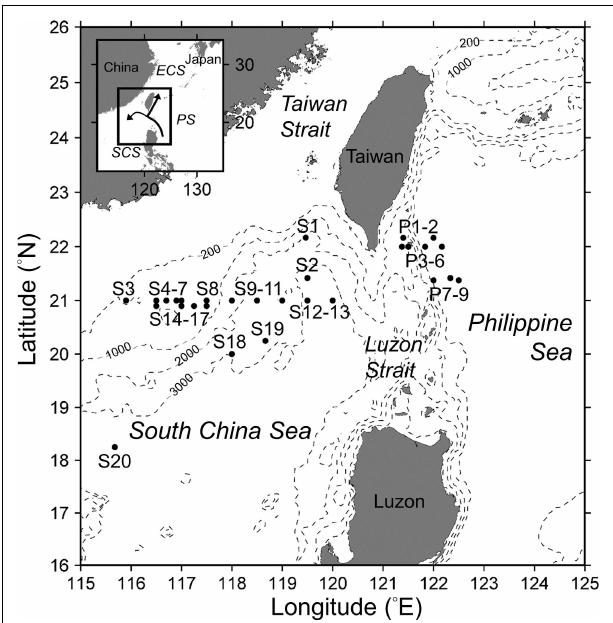
FIGURE 1 | Bottom topography (hatched lines) and locations of sampling stations in the South China Sea (stations S1 to S20) and the Philippine Sea (stations P1 to P9). The arrows in the inset map indicate the path (in the PS) and intrusion (into the SCS) of the Kuroshio (after Caruso et al.,